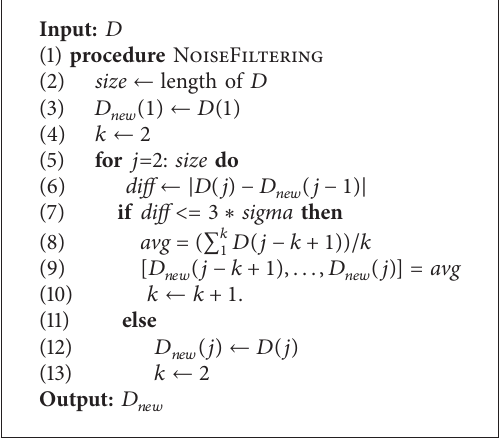
Algorithm 1: Noise filtering